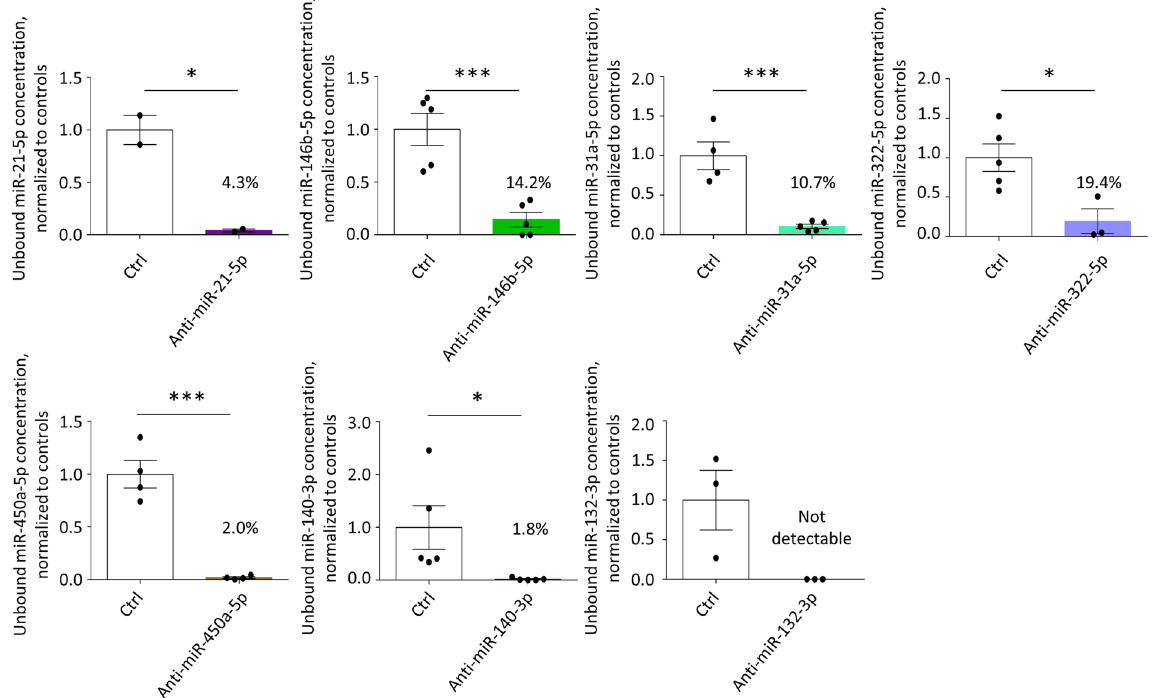
Figure 2. Concentrations of free microRNAs (i.e., not bound to an anti-miR) in EHTs treated with anti-miRs compared to control EHTs (Ctrl) at the end of the experiments, bars show mean ± SEM, n = 2–5 EHTs per